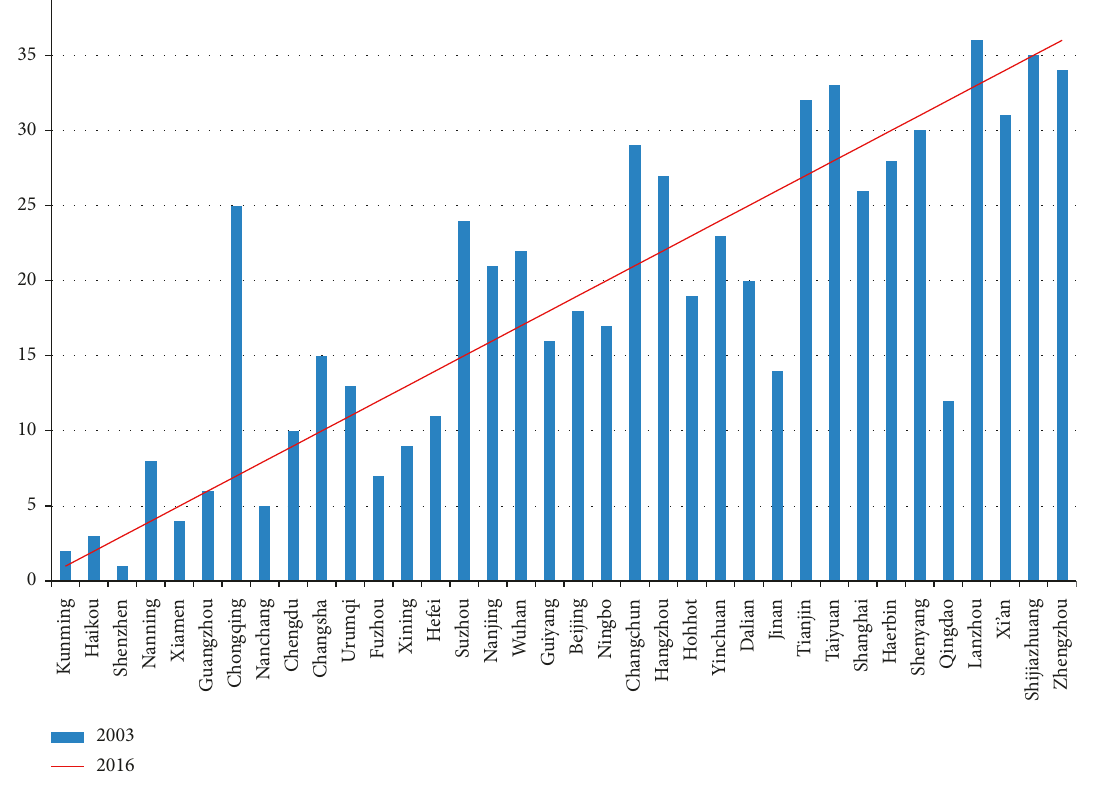
Figure 2: Ranking changes of 36 main cities’ UPE scores in 2003 and